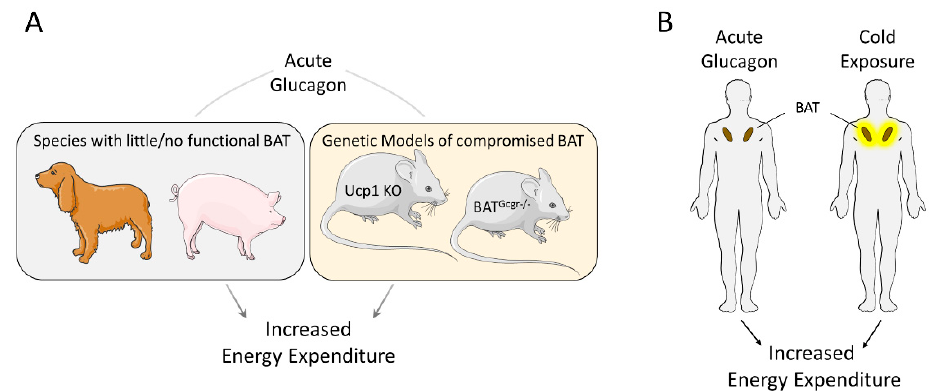
Figure 1. Acute effects of glucagon are not solely mediated by brown adipose tissue (BAT). ( A ) Acute administration of glucagon increases energy expenditure in animal species with little or no functional BAT, like dogs and pigs, and in genetically modified mice lacking functional Ucp1 gene (Ucp1 KO) or glucagon receptor in brown adipose tissue (BAT Gcgr − / − ). ( B ) Both cold exposure and glucagon administration increased energy expenditure to a similar extent, while only cold exposure increased BAT